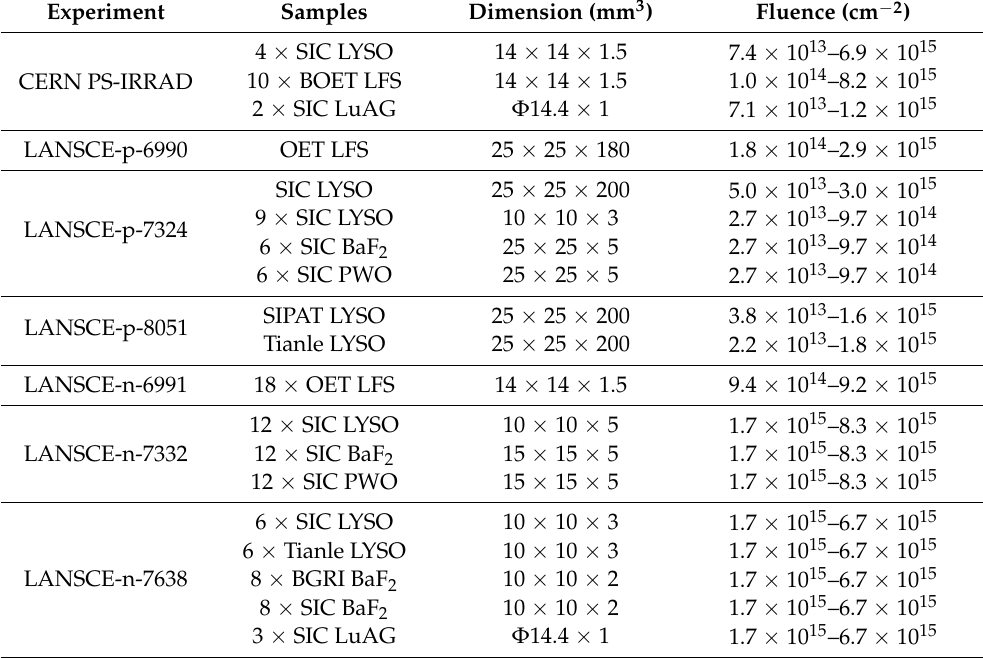
Table 1. Samples used in various proton and neutron irradiation